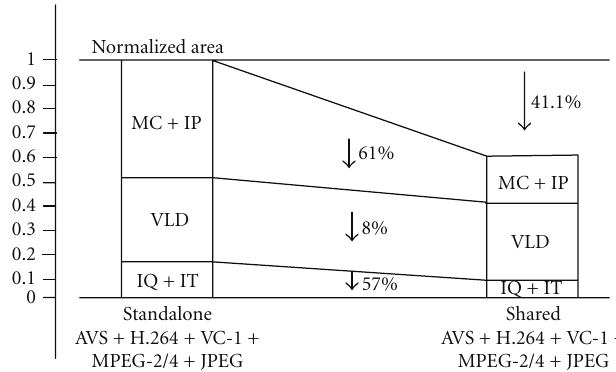
Figure 7: Cost reduction map of a decoder using the proposed architecture.